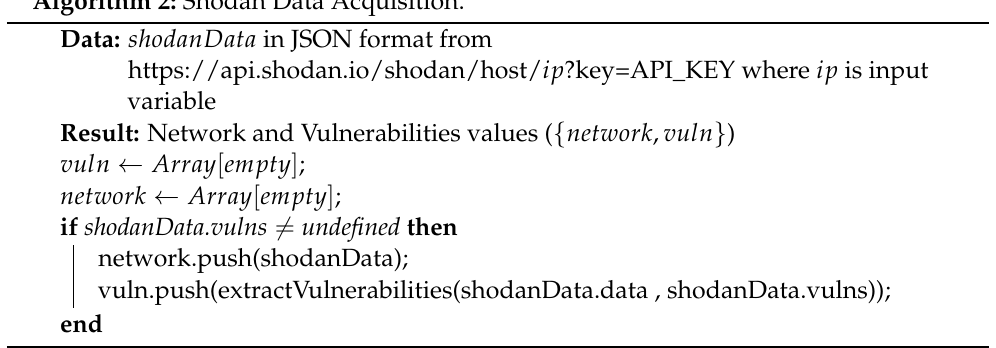
Algorithm 2: Shodan Data